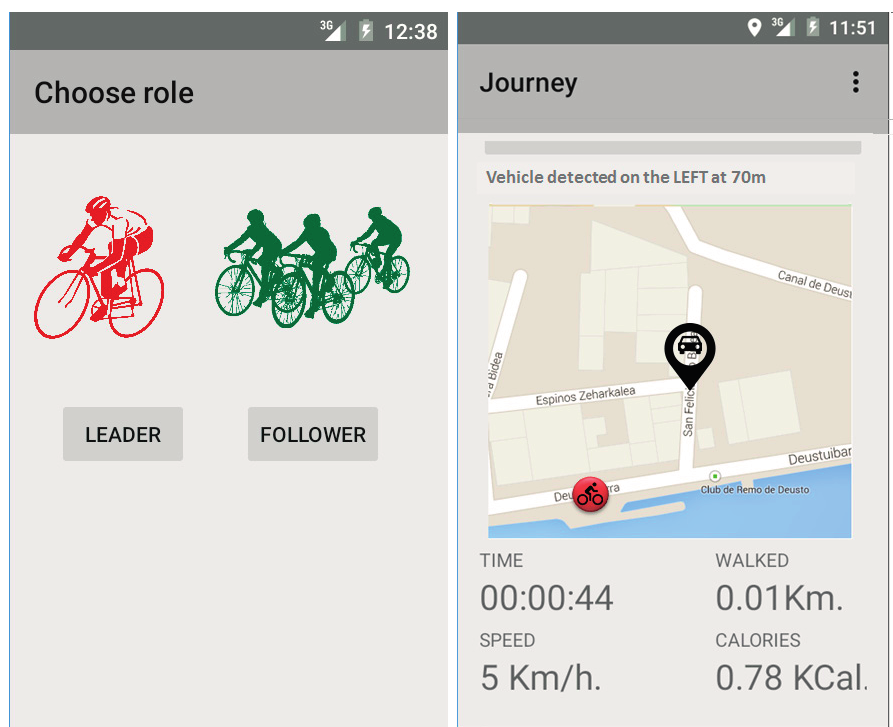
Figure 10. Cyclist application